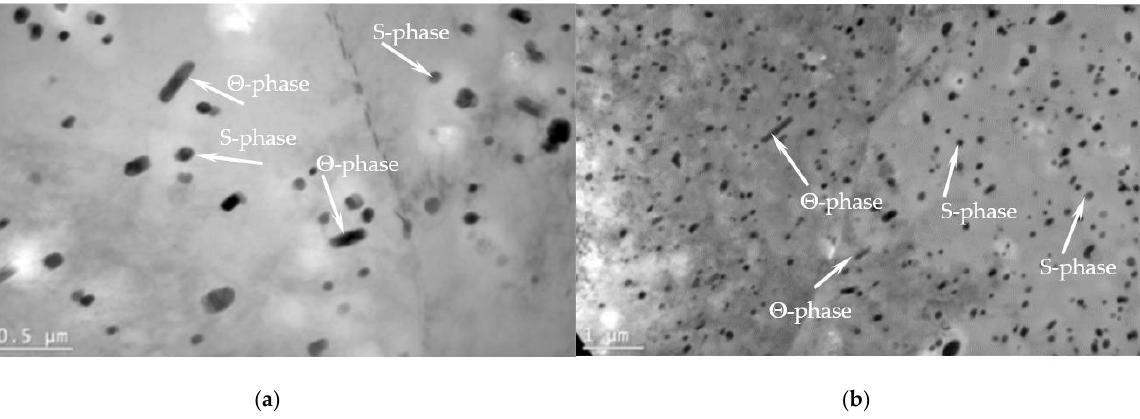
Figure 14. TEM-structures of aluminum alloys in the initial state: ( a ) — alloy 2024-T361; ( b ) — alloy D16ChATW. S-phase and Θ -phase particles are indicated by arrows.